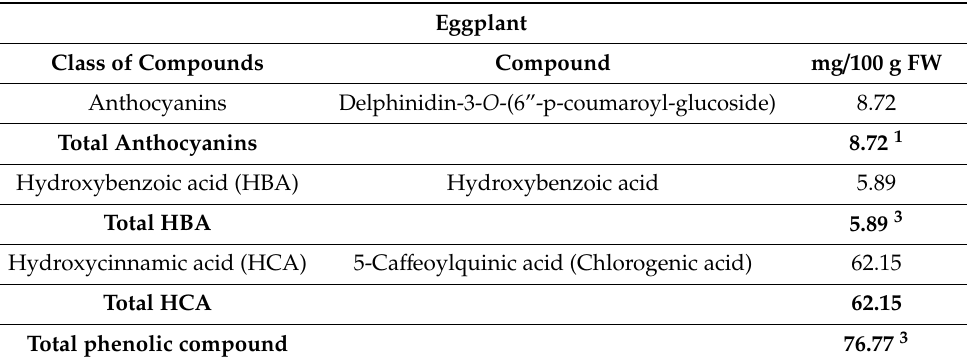
Table 10. Total polyphenolic compounds content in